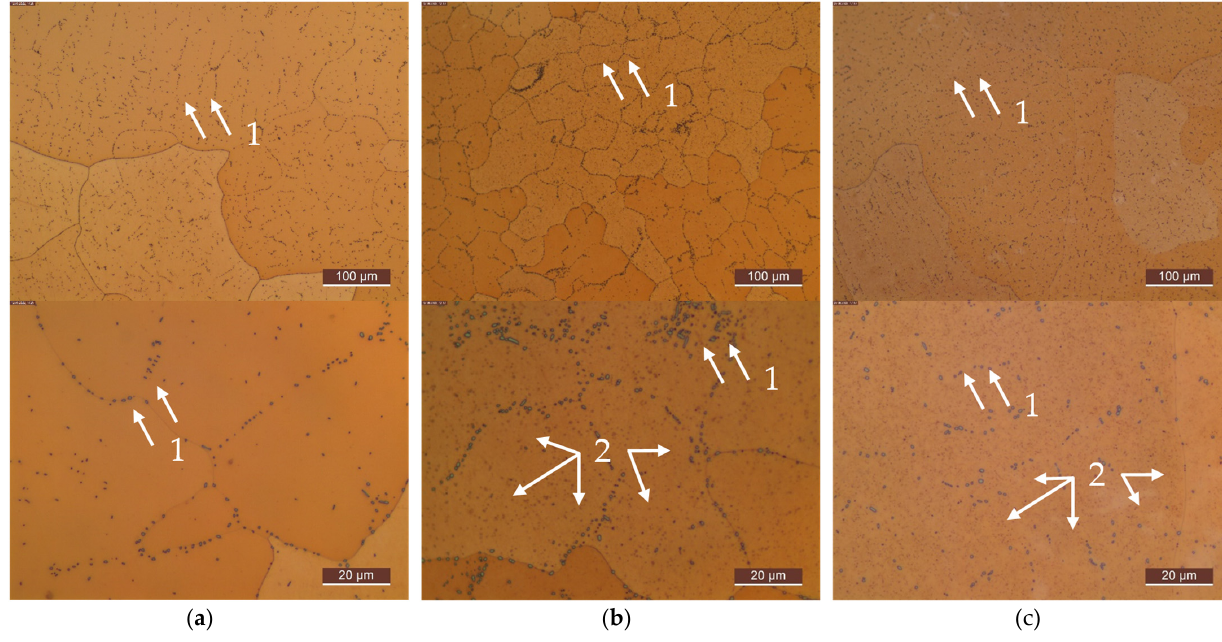
Figure A5. Microstructure evolution of CuCr0.7 during DSC measurements in the optical micro- scope: specimen without cold rolling; ( a ) initial state; and after DSC measurement; ( b ) condition 1; ( c ) condition 2; showing a fine network of undissolved chromium particles (1) and growing Cr-precipitates